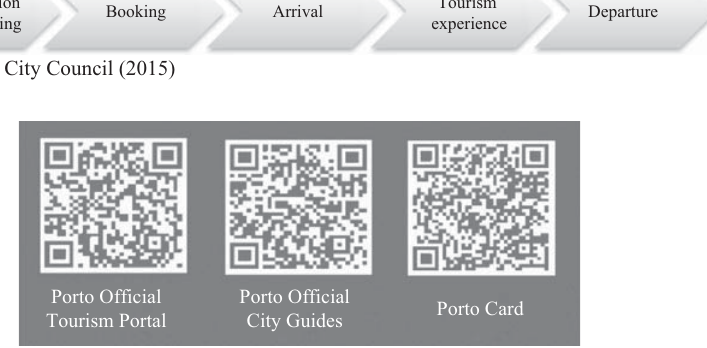
Figure 2. Examples of use of the QR code